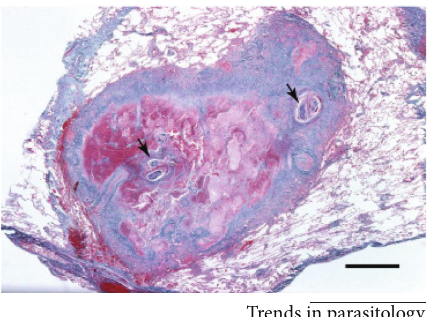
Figure 4: Courtesy of trends in parasitology: a coin lesion excised from a human lung showing a well-demarcated granuloma. Cross sections of the worm are highlighted by the black arrows [8].